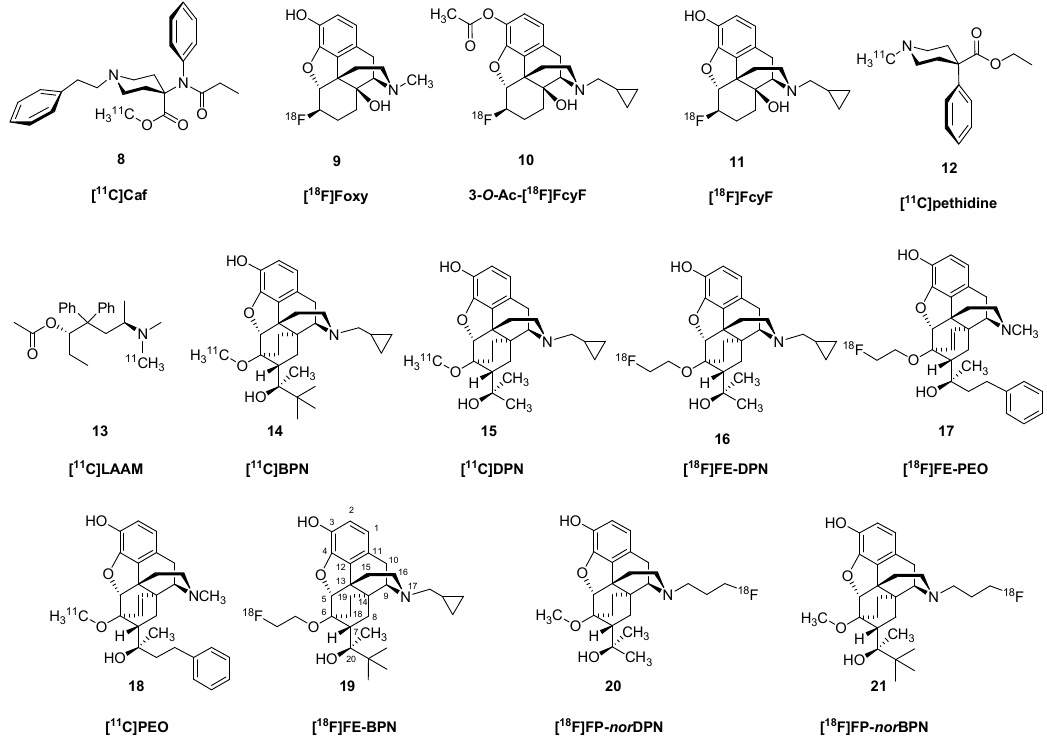
Figure 3. Structures of μ-selective and non-selective opioid receptor radioligands.